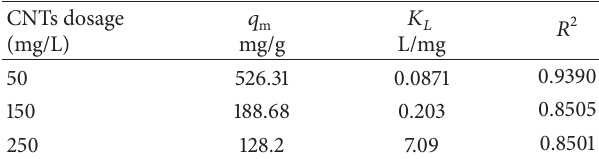
Table 5: Adsorption isotherm constants of Langmuir model for methyl violet dye (pH = 8.5 and contact time =